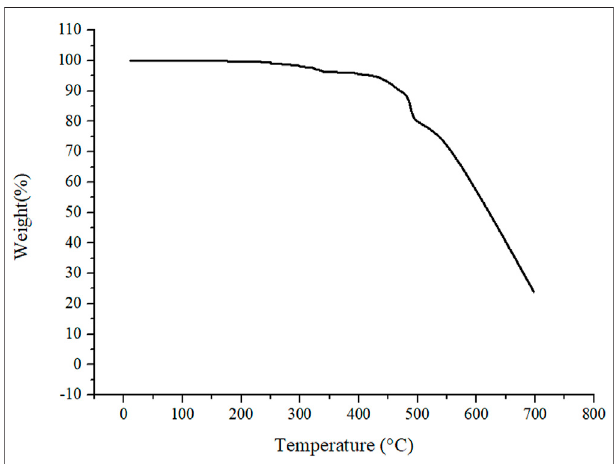
FIGURE 2 | TGA curve of TPP from 20 ° C to 700 ° C at 10 ° C min − 1 under